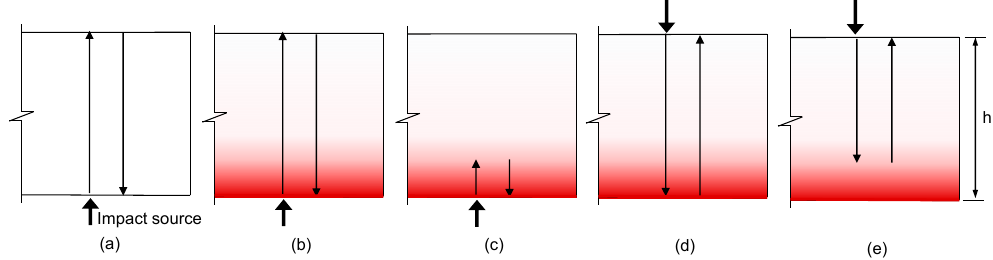
Figure 16. Several possible wave paths of non-propagating waves in solid and fire-damaged concrete slabs: ( a , b , d ) are the multiple reflections of P-waves between the two free surfaces on solid concrete slabs and the fire-damaged concrete slabs, caused by an impact source on either surface of the concrete slab specimen (the bottom surface for ( a , b ), and the top surface for ( d )); ( c , e ) show the multiple reflections of P-waves between a free surface and an internal acoustic reflector at a high impedance mismatch, generated by an impact source on the bottom surface and top surface, respectively. The peak frequency of the thickness stretch mode in the fire-damaged concrete slab was approximated as follows: